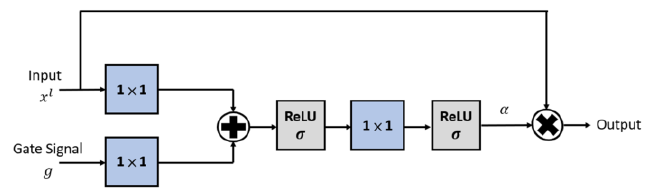
Figure 4. An illustration of an attention gate.